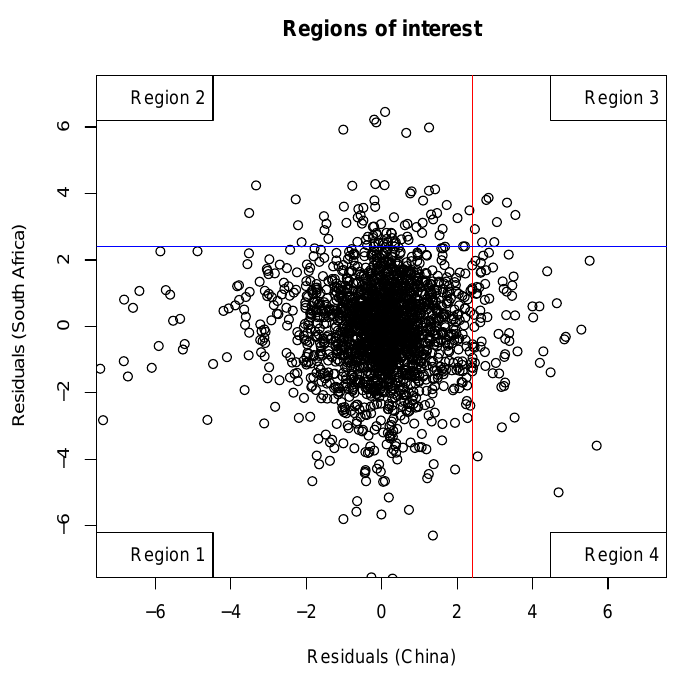
Figure 12. The CMEV and bivariate point process models’ same points thresholds. Table 8. Extremal dependence structures of the CMEV and point process models. Panel A Paired Markets CMEV Model